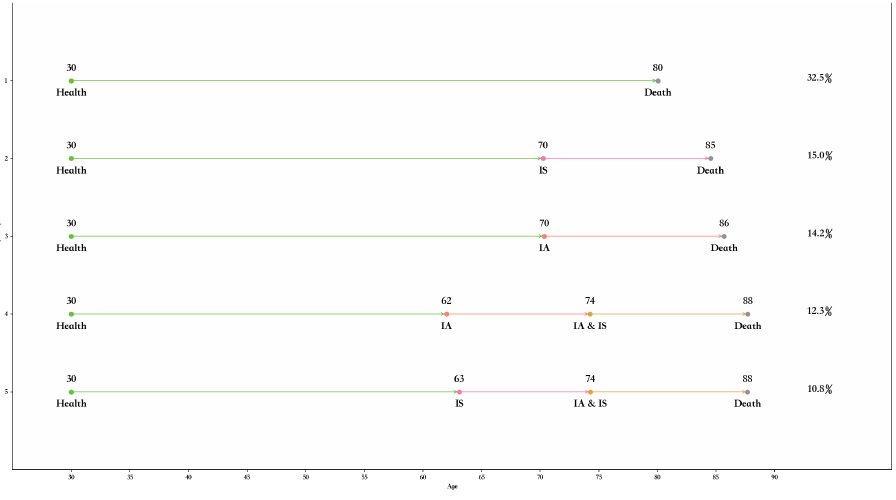
Figure 6. Disease progression trajectory of 2-year interval